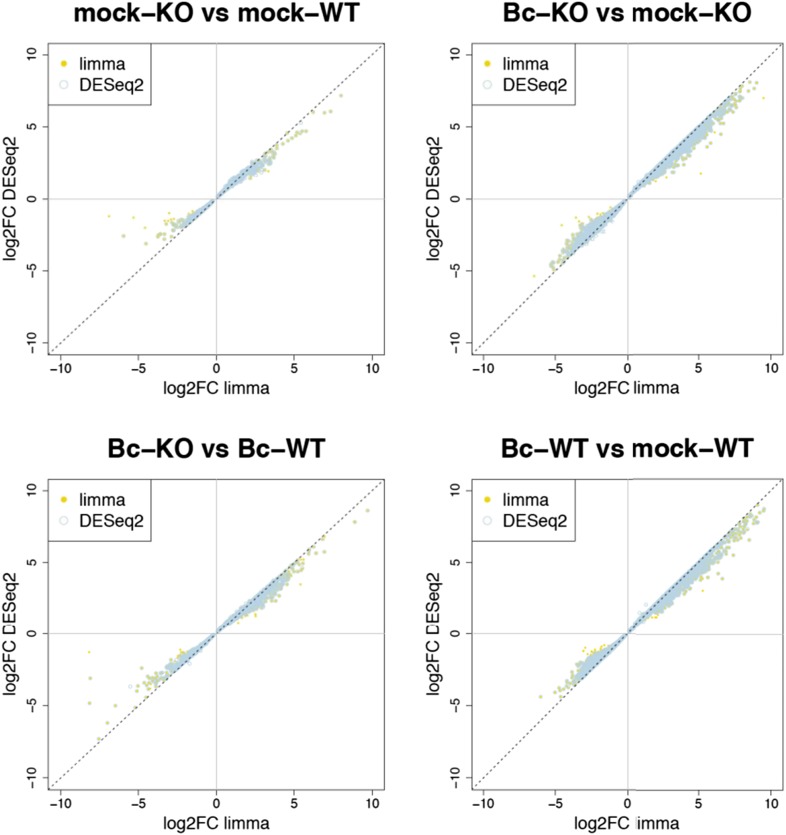
Plots show the correlation between the log2 fold changes obtained for each gene with limma (used in our study) and the alternative tool DESeq2. Yellow points represent genes identified with limma as significantly DE (p adj < 0.05), blue circles represent genes identified with DESeq2, and an overlap of both marks represents genes consistently identified with both tools.